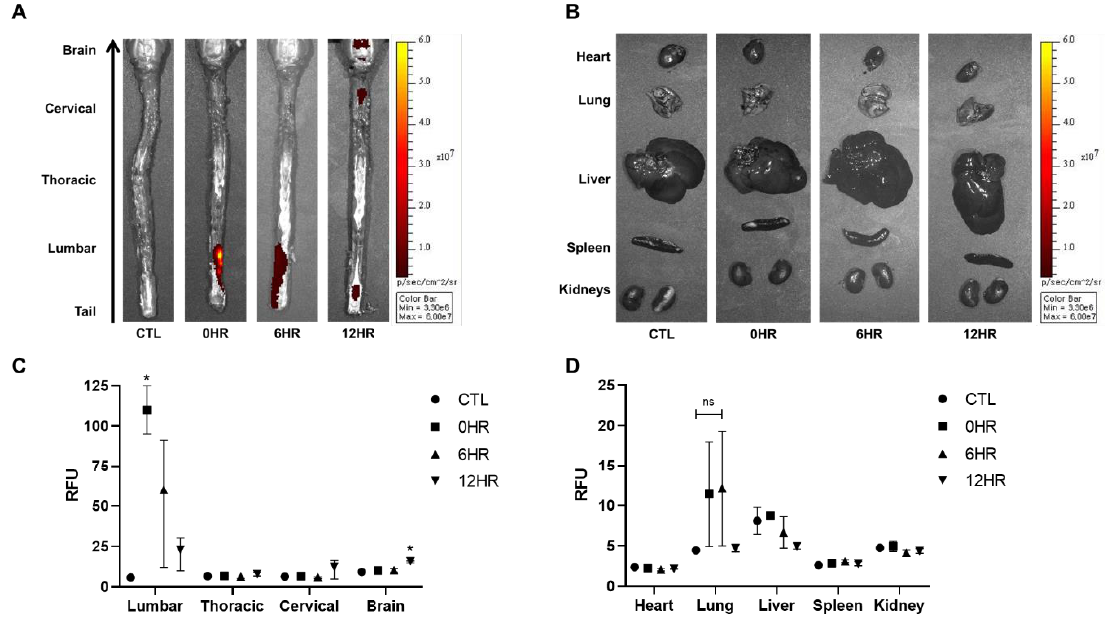
Figure 2. Migration of intrathecally injected Wharton’s jelly-derived mesenchymal stem cells (WJ-MSCs) observed via optical imaging. ( A , B ) Ex vivo optical imaging of the brain, spinal cord, and the various organs was conducted at the respective sacrifice time points (0, 6, and 12 h). The red / yellow gradient scale indicates the intensity of the signal. ( n = 3 / group) ( C , D ) The signal intensities were quantified using Living Image ® 3.1 software. ( n = 3 / group) mean with range. * p -value < 0.05 compared to the control group (CTL) of each tissue.